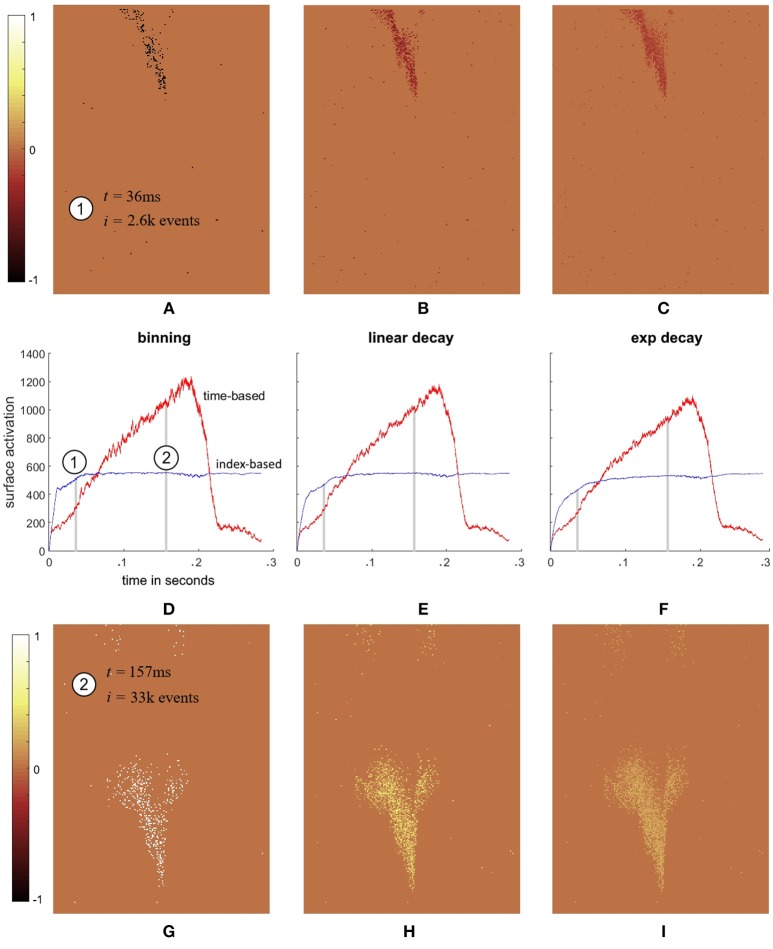
Comparison of surface activation for a single recording. (A–C) show the surface differences (BTSi − BISi), (LTSi − LISi), and (ETSi − EISi), respectively at the beginning of the recording (t = 36 ms). This moment in the recording is marked (1) on (D) which displays total surface activation for the binning method ∑x,yBTSi and ∑x,yBISi. The two traces in (D) show that at the beginning of the recording when the target airplane's speed is low the binning time surface has a lower activation than the binning index surface. However, as the target speeds up, the total time surface activation also increases, while the index surface remains approximately stable, such that by t = 157 ms the time surface activation ∑x,yBTSi is approximately twice that of ∑x,yBISi. (E,F) show a similar but slightly less pronounced relative increase for the linear and exponential decay surfaces. (G–I) show this relative increase for the binning, linear, and exponential decay surfaces by plotting the differences of (A–C) at t = 157 ms.